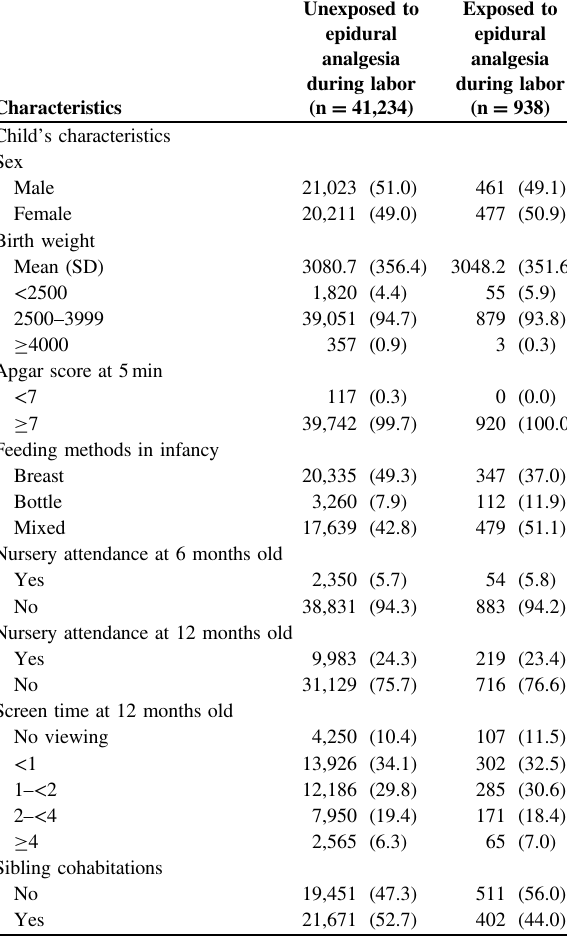
Table 1 Characteristics of study